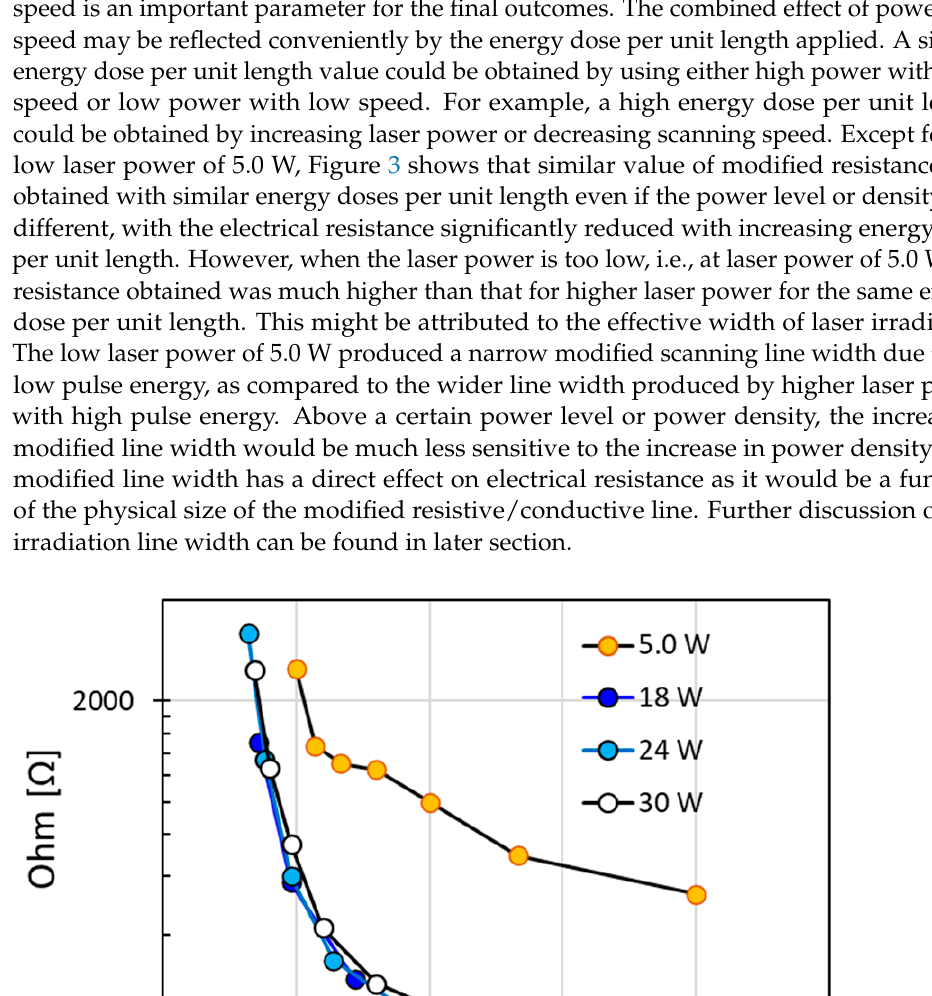
Figure 1. Electrical resistance decreased with increasing laser power with a single pass scanning at a scanning speed of 12.5 mm/s and power modulation repetition rate of 90 kHz.